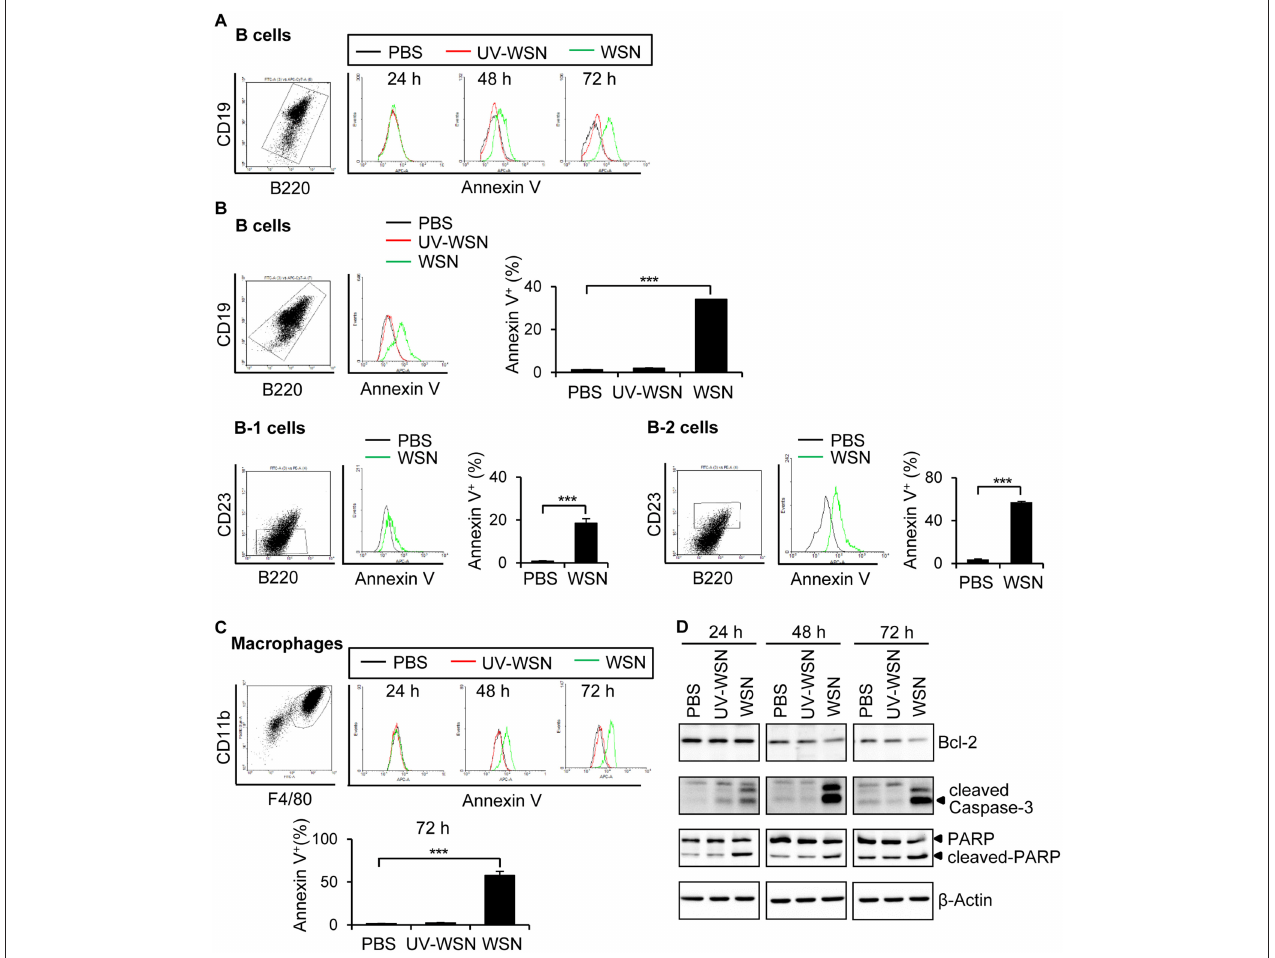
FIGURE 3 | Peritoneal cells undergo apoptosis after A/WSN/1933 virus infection. (A) BALB/c mice ( n = 3/group) were sacrificed, and peritoneal cells were harvested. The cells (1 × 10 6 ) were seeded into 24-well plates containing RPMI 1640 complete media, and then treated with 1 × 10 6 pfu of A/WSN/1933 virus (WSN) or UV-WSN virus (UV-WSN). After incubation for 24, 48, or 72h, the cells were stained with fluorescence-conjugated antibodies (CD19, B220) and Annexin V. After washing, PI detection kit was used to discard dead cells and then analyzed by flow cytometry. Annexin V-positive B cells are represented in histograms. (B) Peritoneal cells (1 × 10 6 ) were treated with 1 x 10 6 pfu of A/WSN/1933 virus (WSN) or UV-WSN virus (UV-WSN) for 72h, the cells were stained with fluorescence-conjugated antibodies (CD19, B220, CD23, 7AAD) and Annexin V. Annexin V-positive B cells are represented in histograms. Each right panel of (B) shows the % of annexin V-positive B cells, B-1 cells, and B-2 cells. (C) Peritoneal cells (1 × 10 6 ) were treated with 1 x 10 6 pfu of A/WSN/1933 virus (WSN) or UV-WSN virus (UV-WSN). After incubation for 24, 48, or 72h, the cells were stained with fluorescence-conjugated antibodies (CD11b, F4/80) and Annexin V. After washing, PI detection kit was used to discard dead cells and then analyzed by flow cytometry. Annexin V-positive macrophages are represented in histograms. Lower panel of (C) shows the % of annexin V-positive macrophages. (D) Time-dependent expression of Bcl-2, cleaved Caspase-3 and cleaved PARP was determined by western blotting. Each figure is representative of three independent experiments. *** P <